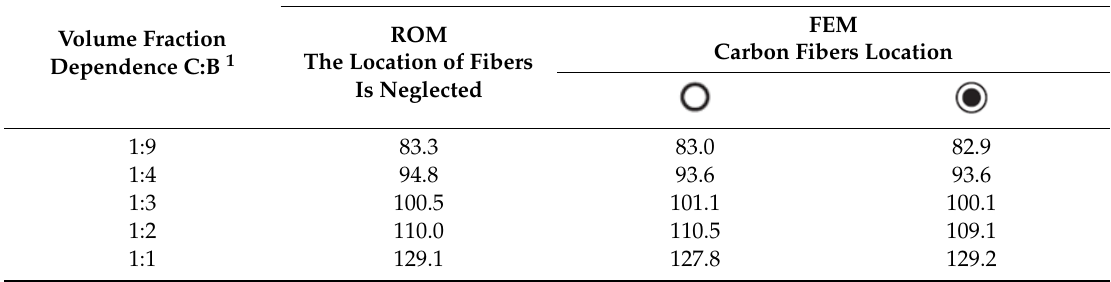
Table 1. Comparison of Young’s modulus obtained from rule of mixtures (ROM) and finite element methods (FEM) modeling.